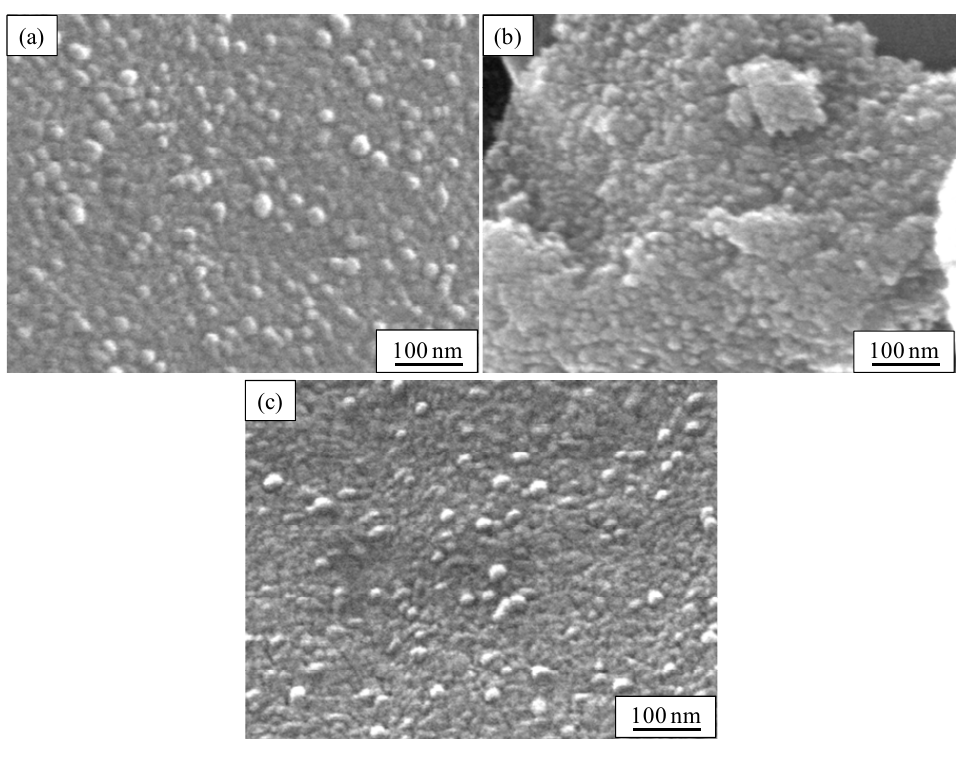
Figure 1. SEM images of ( a ) Sample T; ( b ) Sample S300, and ( c ) Sample